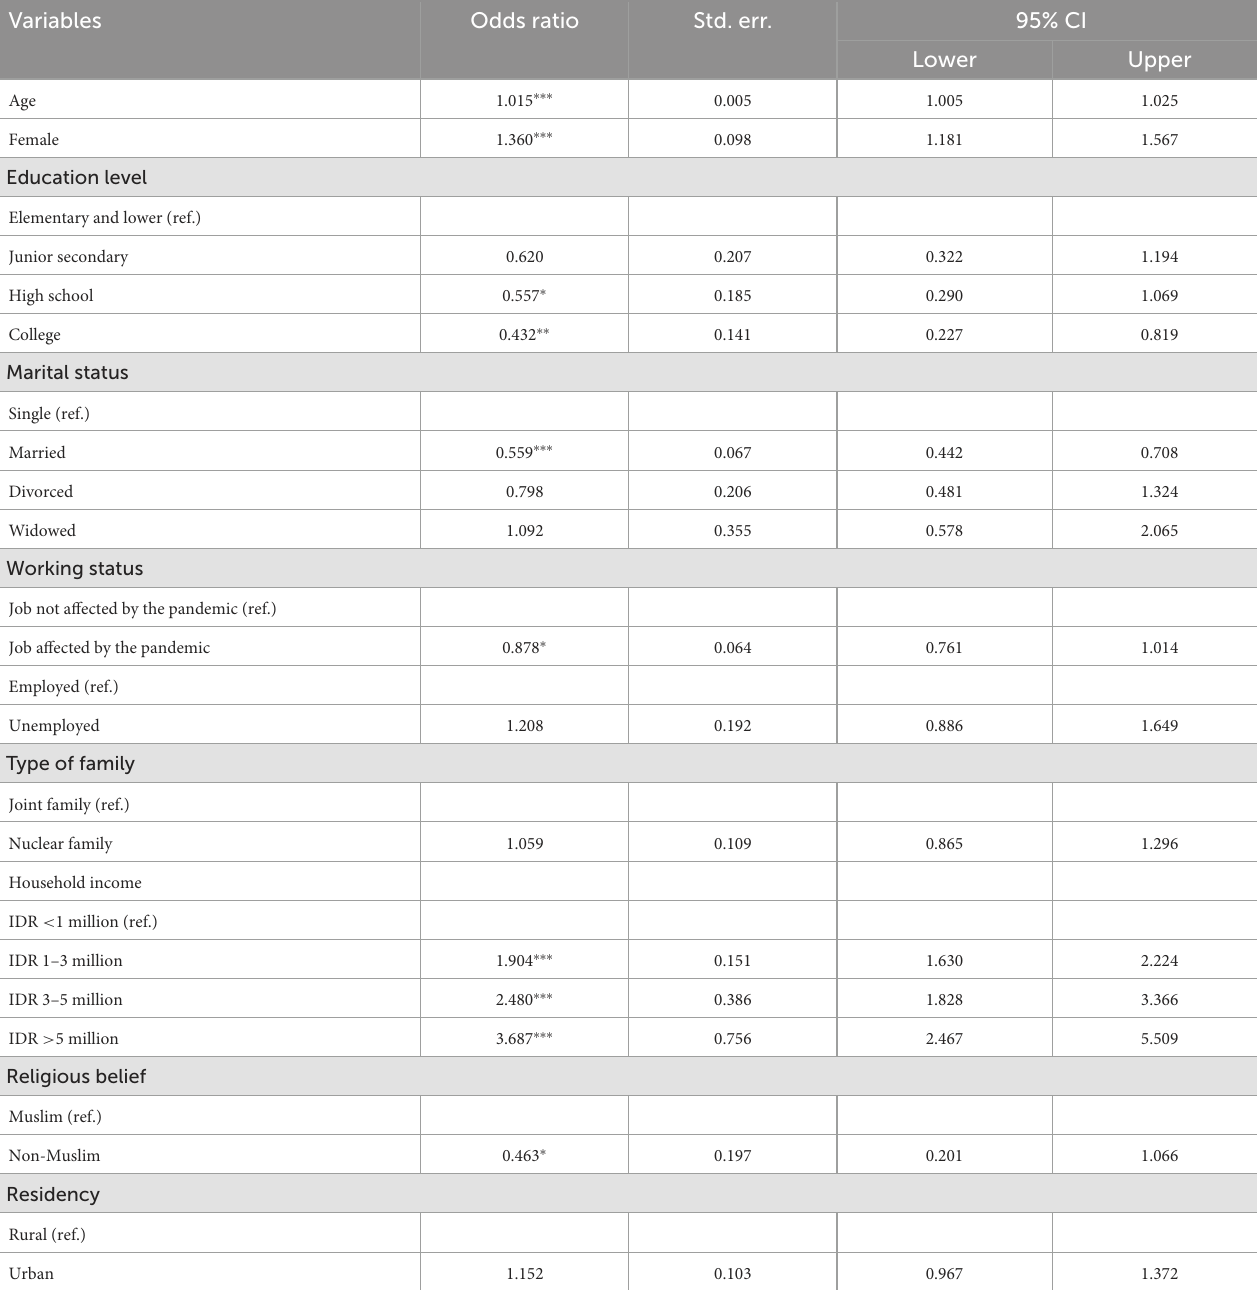
TABLE 3 Results of multivariate ordered logistic regression measuring the association of socio-demographic variables of interest with COVID-19 vaccine hesitancy. Variables Odds